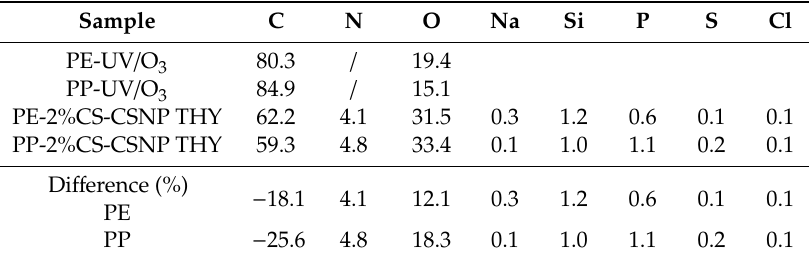
Table 5. Surface chemical composition (at. %) of the reference foils and foils treated by the two-layer coating: 2%CS-CSNP THY (at. %).